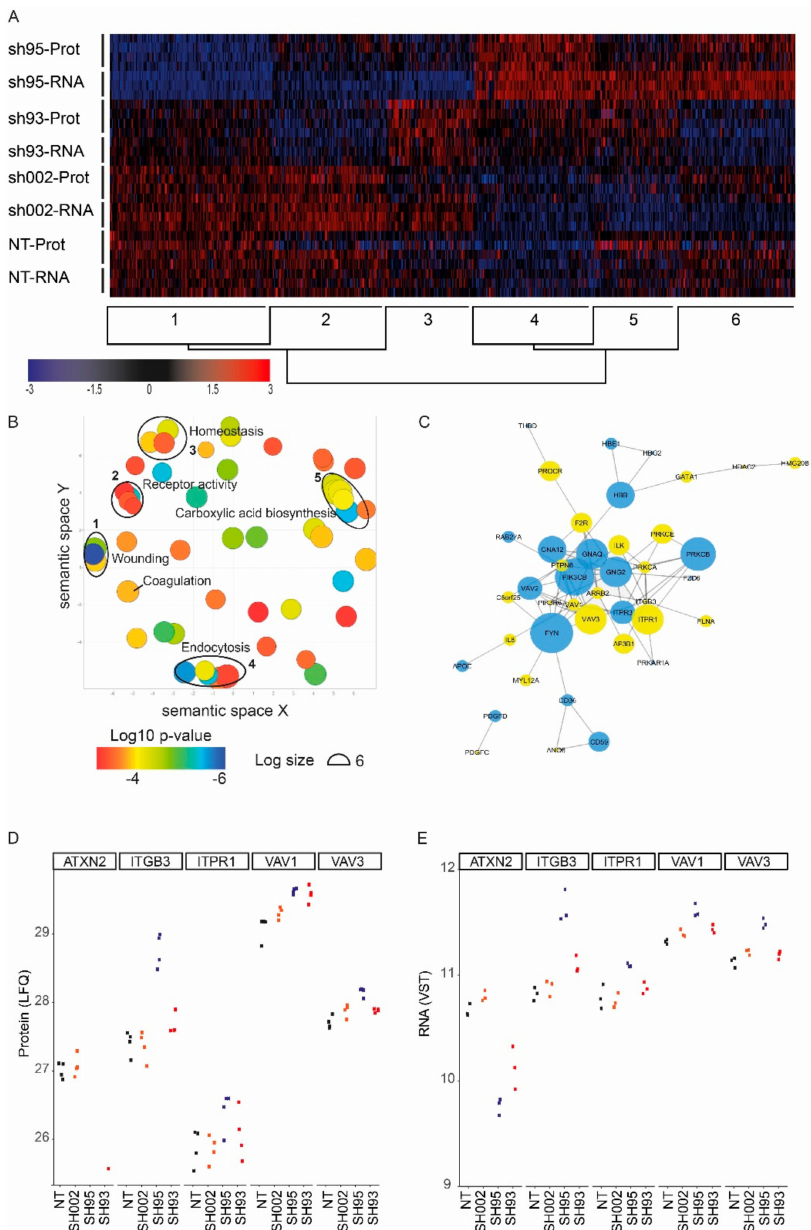
Figure 4. Gene ontology analysis links ATXN2 to platelet-related or haemostasis pathways. ( A ) Hierarchical clustering of genes that are di ff erentially expressed at the RNA level between sh002 (control) and sh95 transduced MEG-01 cells (FDR < 0,05) and significantly detected by mass spectroscopy. (row clusters, k = 6, blue = downregulated, red = upregulated). Genes are listed in Supplemental Table S2. These genes were subjected to GO Term enrichment analysis. ( B ) Deregulated processes upregulated upon ATXN2 depletion were visualized with REVIGO, clustering similar GO terms together in a semantic space (full list of GO terms in Supplemental Table S5). Closely related GO terms were encircled, numbers correspond to column “RIVIGO” in Supplemental Table S2. ( C ) STRING analysis of deregulated genes associated to the GO term coagulation, blue downregulated and yellow upregulated genes. Node size corresponds with known interactions (more = larger) with other proteins within the cluster. ( D,E ) Expression level of ATXN2 and a selection of genes that are associated with platelet function in non-transduced cells (NT), sh002 control, sh95 or sh93 transduced MEG-01 cells measured by ( D ) label-free quantification (LFQ) of protein and ( E ) variance-stabilizing transformed (VST) mRNA